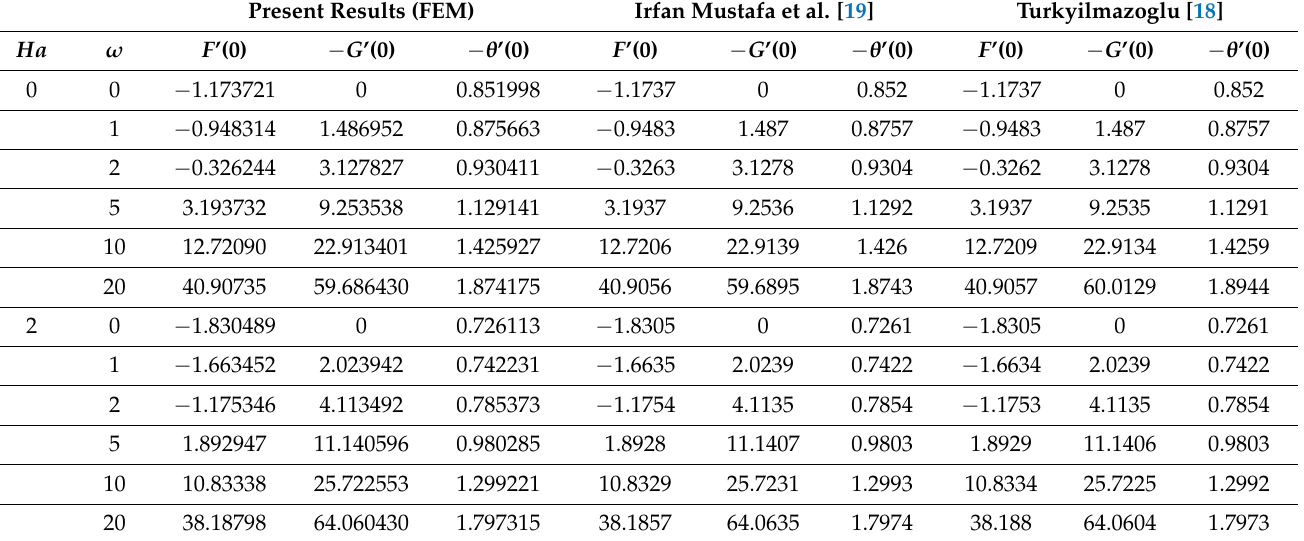
Table 1. Comparison of the FEM results with those in Irfan Mustafa et al. [19] and Turkyilmazoglu